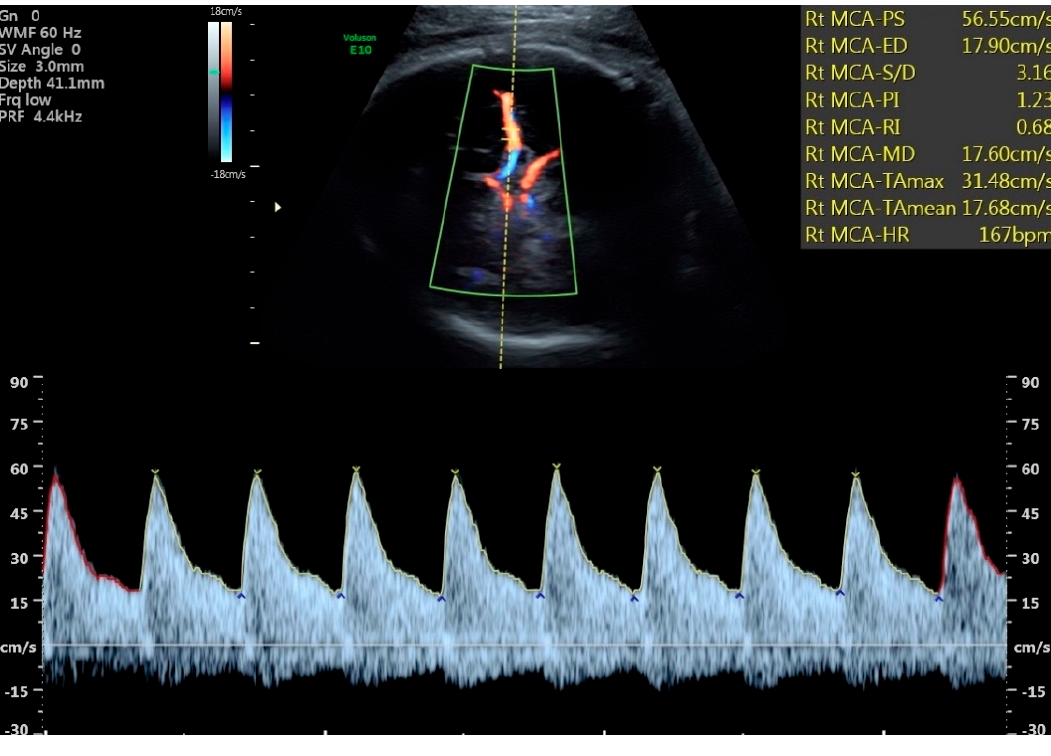
Figure 1 . Mid cerebral artery Doppler with brain sparing.